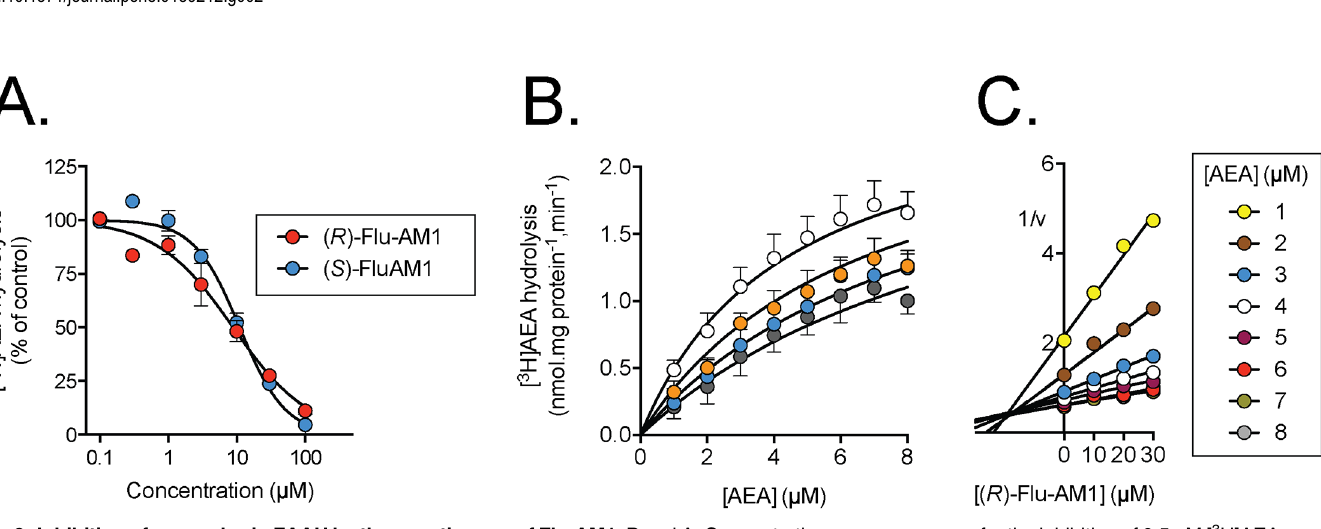
Fig 3. Inhibition of mouse brain FAAH by the enantiomers of Flu-AM1. Panel A. Concentration response curves for the inhibition of 0.5 μ M [ 3 H]AEA (means ± s.e.m., n = 3, when not enclosed by the symbols). Panel B. Kinetic experiments using 1 – 8 μ M [ 3 H]AEA (means ± s.e.m., n = 3, when not enclosed by the symbols). The curves were better fitted by a model assuming a competitive interaction (75% probability that it was correct, Akaike ’ s informative criteria) than a model assuming a mixed-type interaction (25% probability that it was correct, Akaike ’ s informative criteria). Panel C. Dixon replot of the mean data from Panel B. The intersection point of the regression lines projected onto the x-axis gives-K i